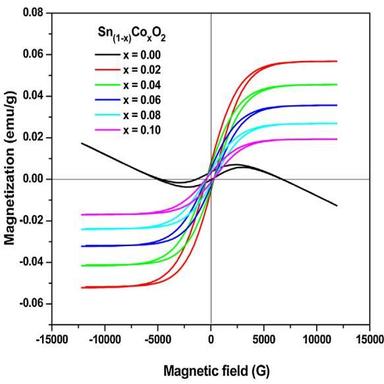
M−H hysteresis curves of Sn1−xCoxO2 (with 0 ≤ x ≤ 0.10) nanoparticles.